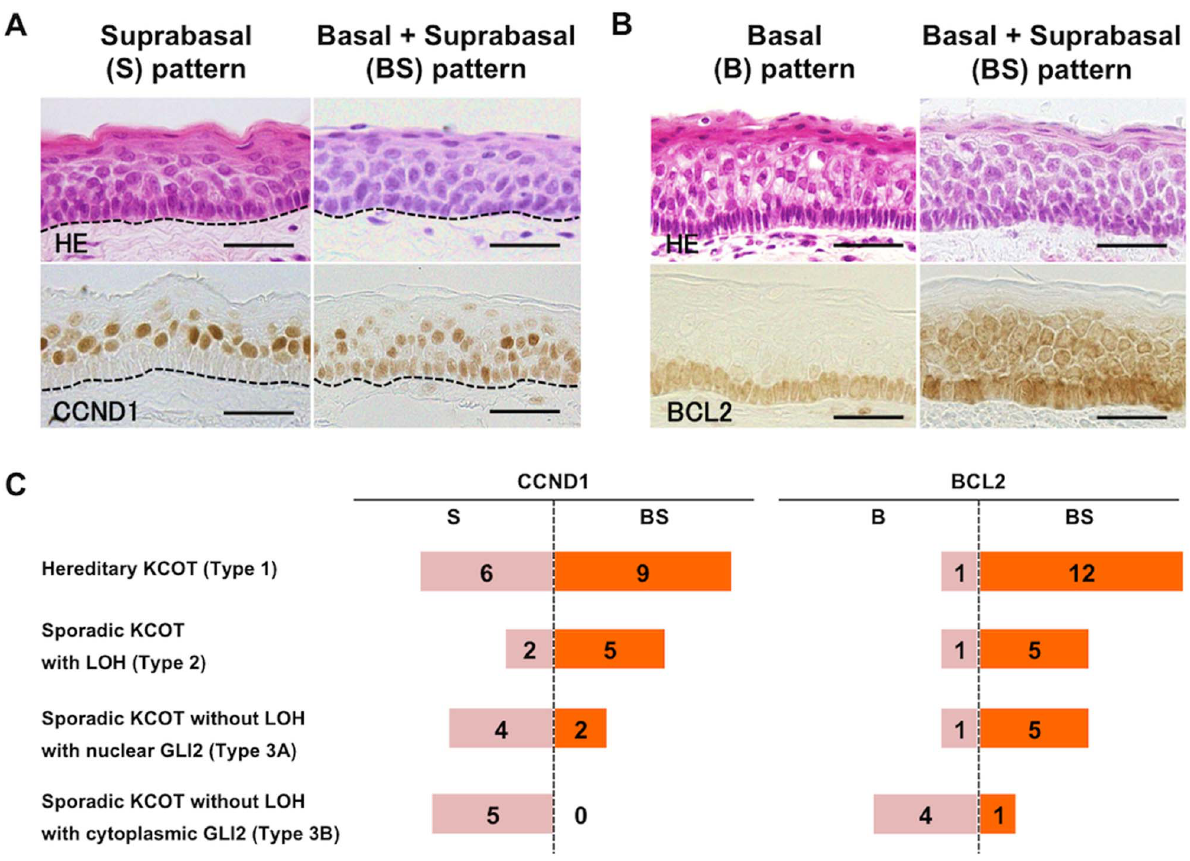
Figure 3. Immunohistochemical expression of CCND1 and BCL2 in KCOT. A) CCND1. Each case was classified either as the basal and suprabasal (BS) pattern or the suprabasal-dominant (S) pattern. The basal-dominant (B) pattern was not observed. The dotted line indicates a basement membrane. Scale bars=30 m m. B) BCL2. Each case was classified either as the basal and suprabasal (BS) pattern or the basal-dominant (B) pattern. The suprabasal-dominant (S) pattern was not observed. Scale bars=30 m m. C) Schematic table of the CCND1 and BCL2 expression patterns in each subgroup. Number of cases with the designated expression patterns are depicted (see also Table 1). The cases in which the examiners’ evaluation split were